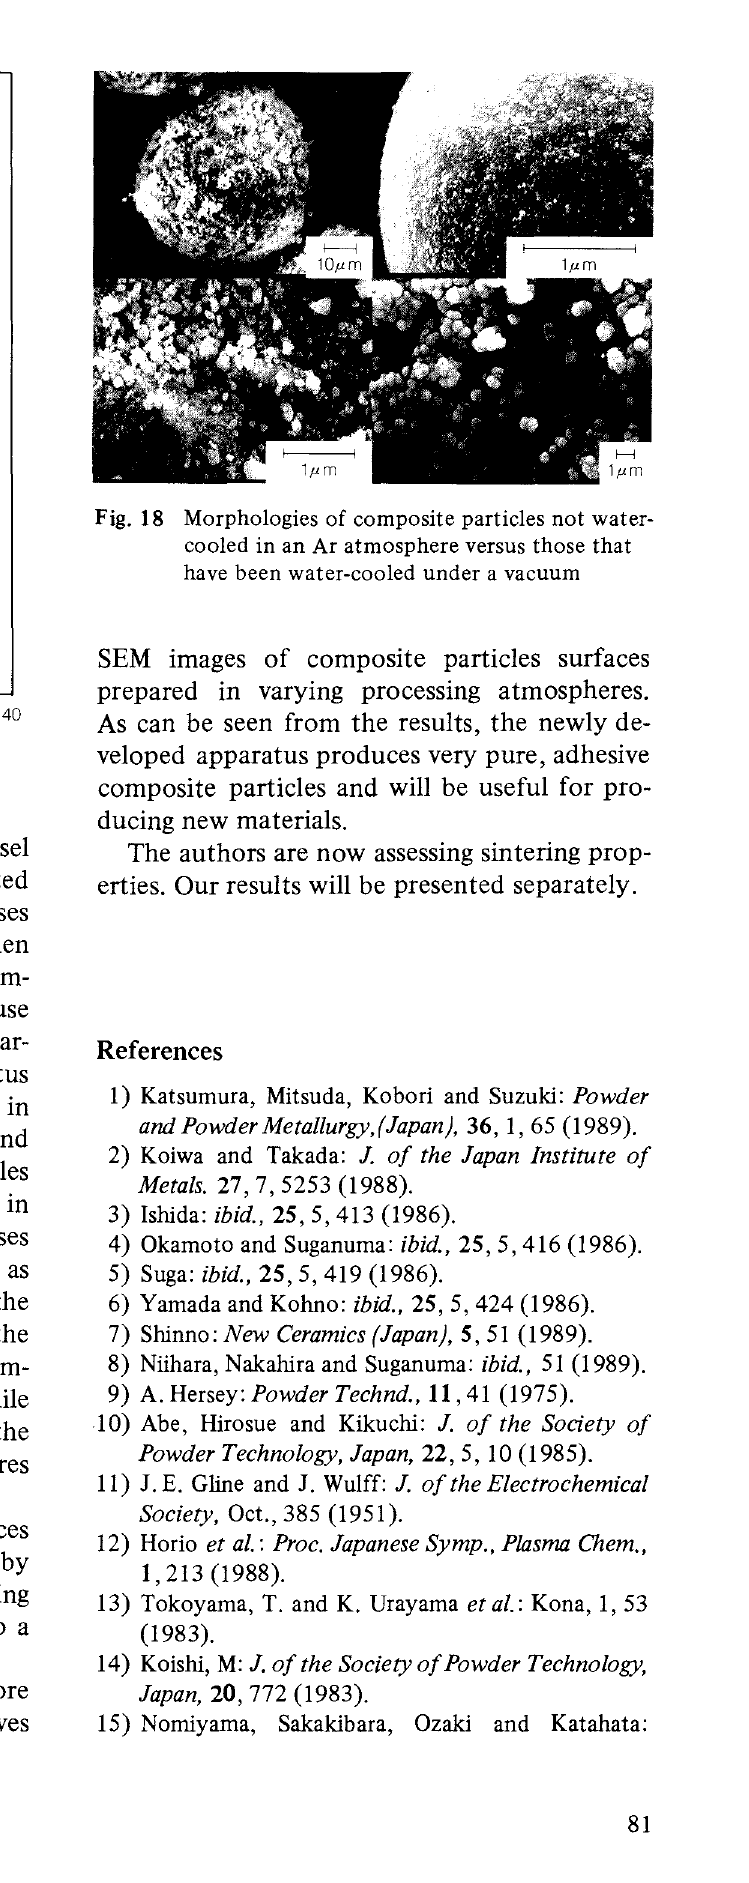
SEM images of composite particles surfaces prepared in varying processing 40